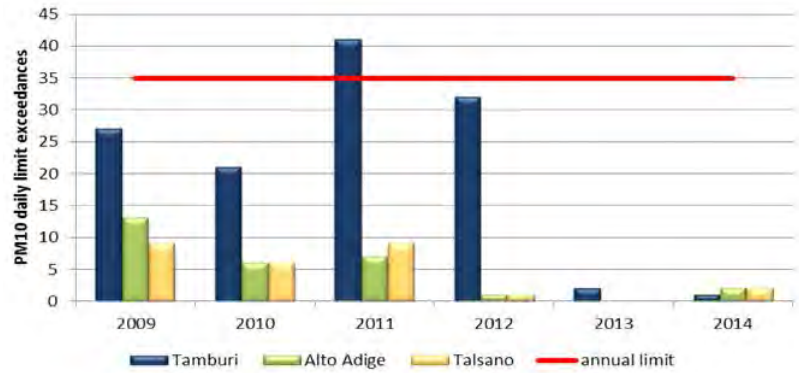
Fig. 5: PM10 daily exceedances from 2009 to 2014